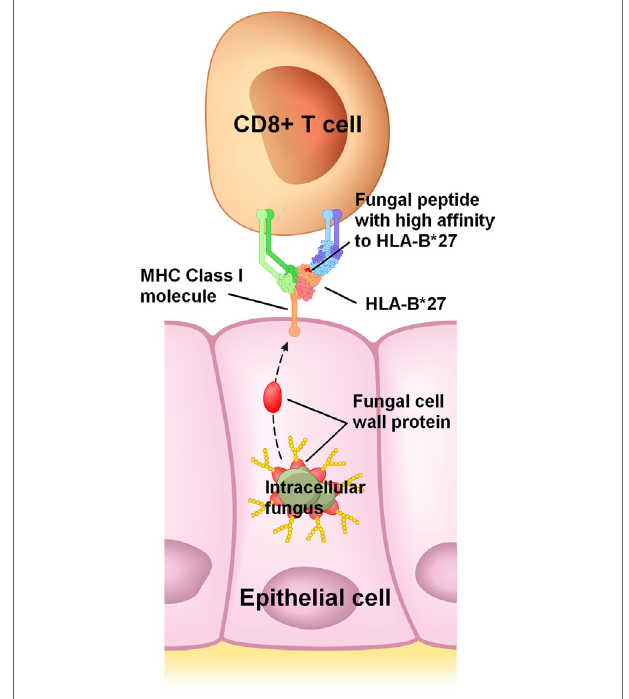
FiGUre 1 | Proposed mechanism for HLA-B*27 in spondyloarthritis. HLA-B*27 would efficiently bind to a peptide from an abundant protein present in or on an intracellular fungus, and then present this peptide to CD8 + T cells on the infected host cell’s surface. In this example, a peptide from a fungal cell wall mannoprotein is presented to a CD8 + T cell. Cell wall mannoproteins are good antigen candidates due to their abundance, though presentation of peptides from other fungal proteins is also